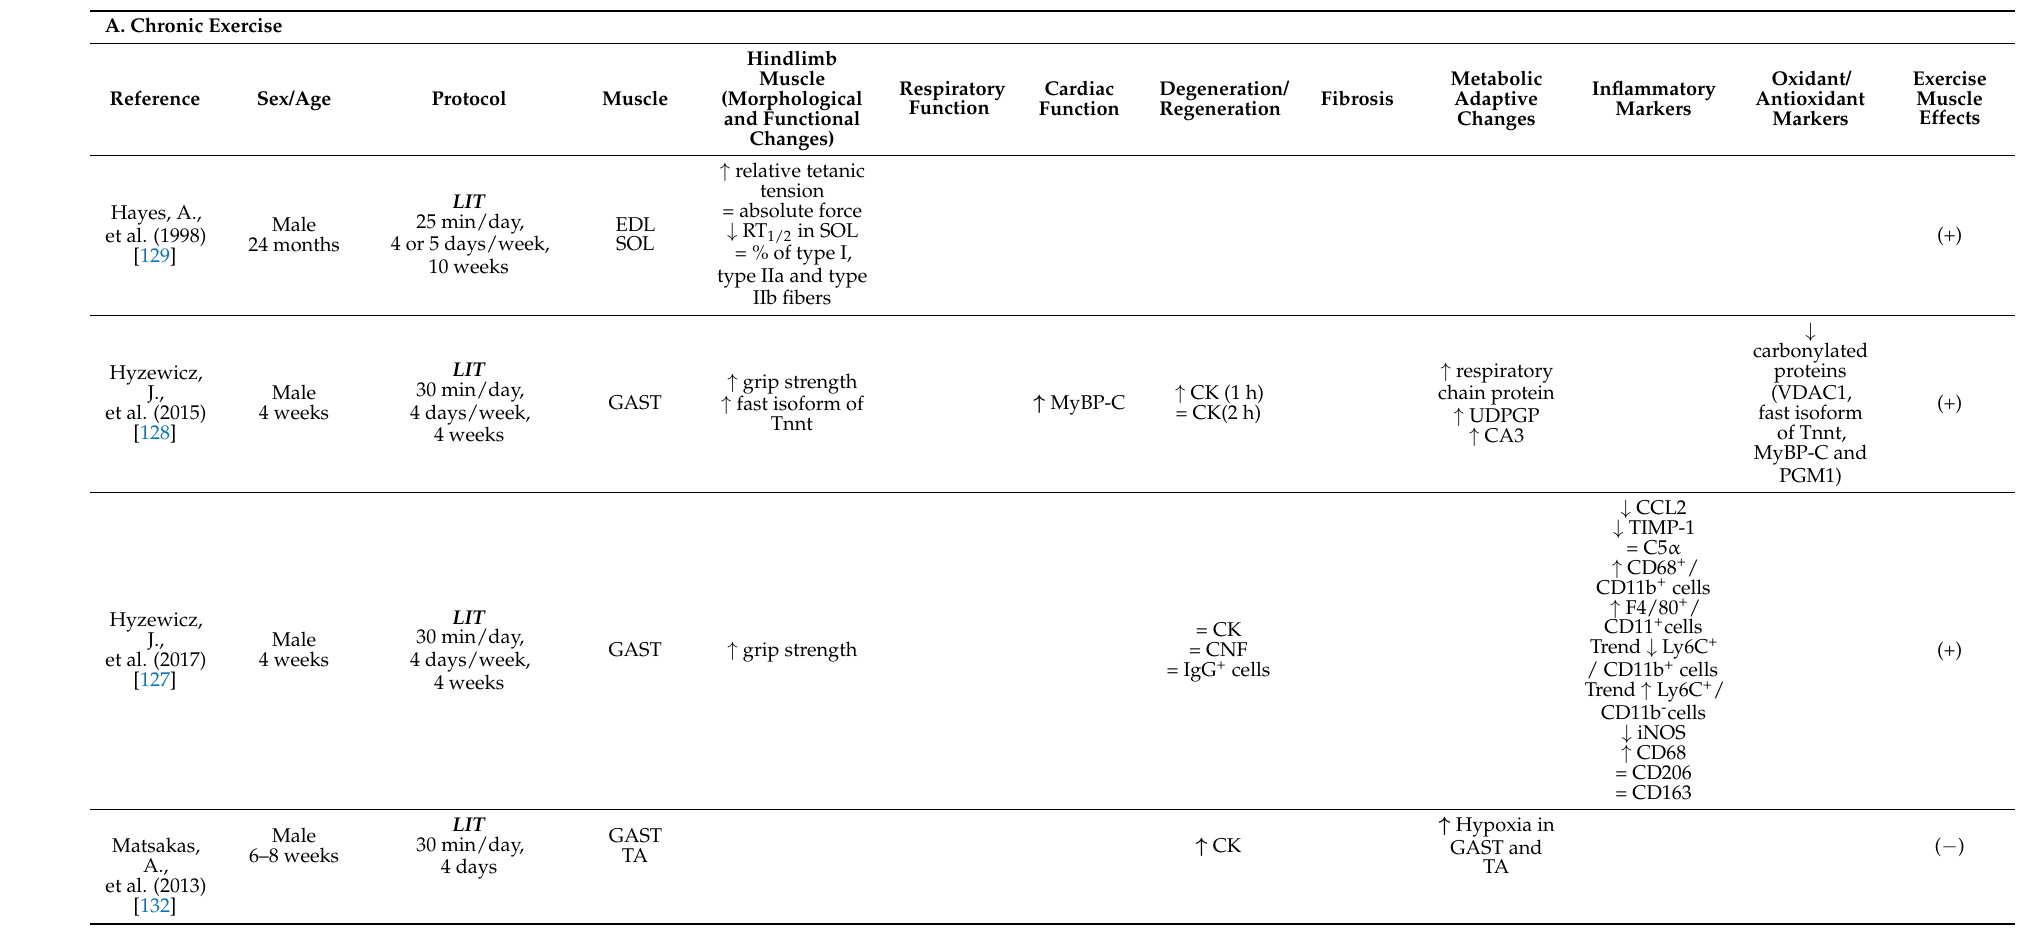
Table A3. Effects of swimming on mdx mouse